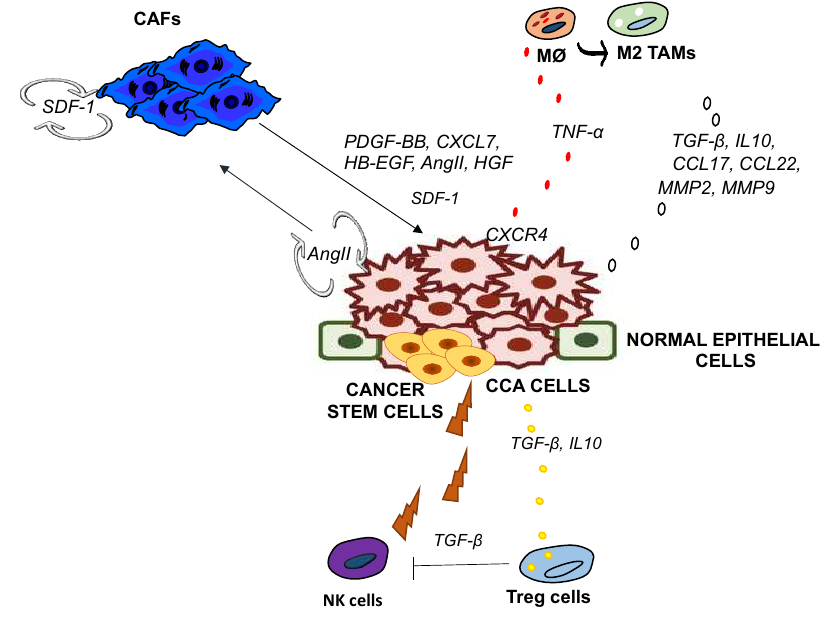
Figure 1. Cross-talk among CCA cells, CAFs, and tumor-associated macrophages (TAMs). Angiotensin II (AngII) released by cancer cells acts both in an autocrine and paracrine fashion. Stromal-derived factor I (SDF-1) expressed by CAFs increases upon AngII stimulation. SDF-1, AngII, PDGF-BB, HB-EGF, CXCL7, HGF released by CAFs promote tumor growth. Tumor Necrosis Factor (TNF- α (produced by TAMs enhance CXCR4 expression (receptor of SDF-1) in CCA. M2 TAMs favour tumor progression through the release of anti-inflammatory cytokines, chemokine and metalloproteinase. Treg cells mediate CCA tolerance producing anti-inflammatory cytokines and inhibiting Natural Killer (NK) antitumor activity.